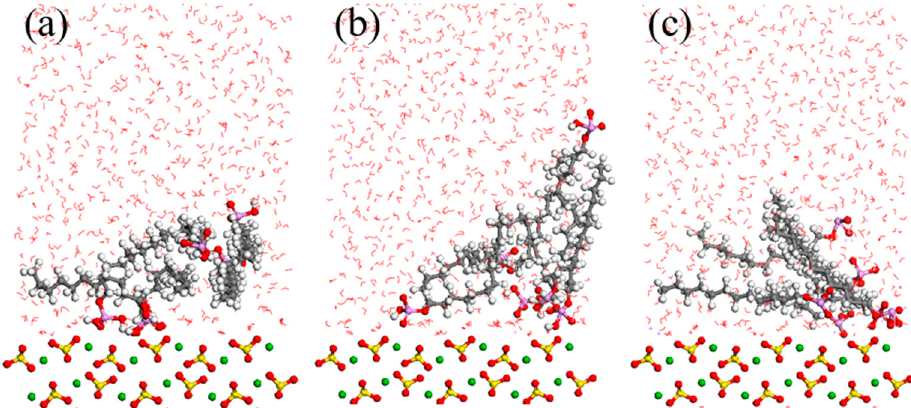
Figure 5. Interfacial behavior of lauryl phosphate species ( a ) RH 2 , ( b ) RH − , and ( c ) R 2 − at barite (001) surface.